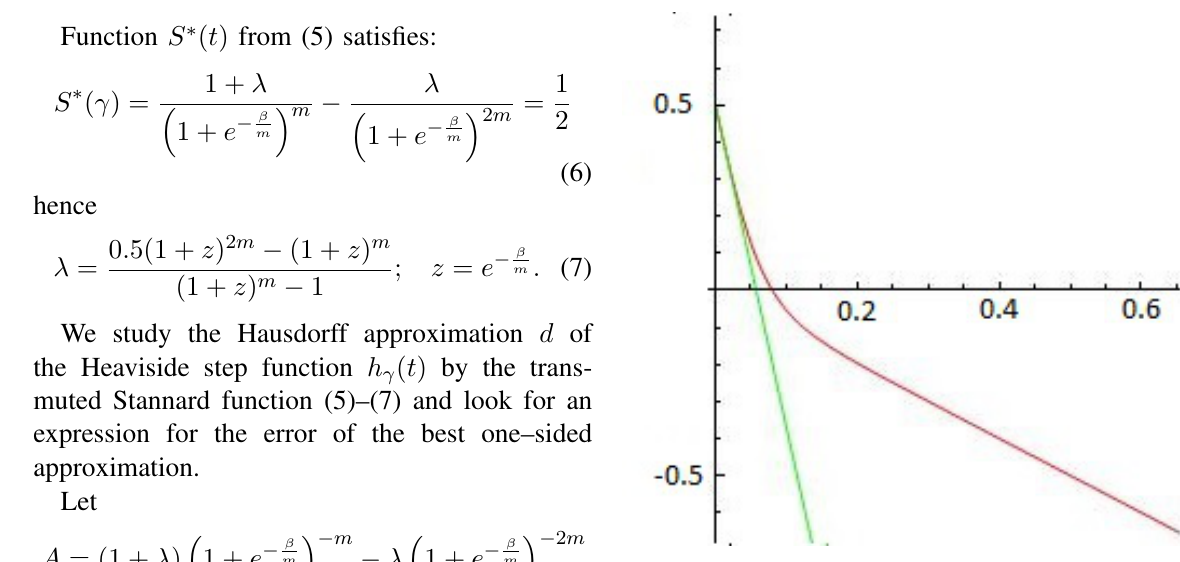
Fig. 3. The functions F ( d ) and G ( d ) for k = 16 , m = 0 . 52 , β = 0 . 01 , t r = 5 .